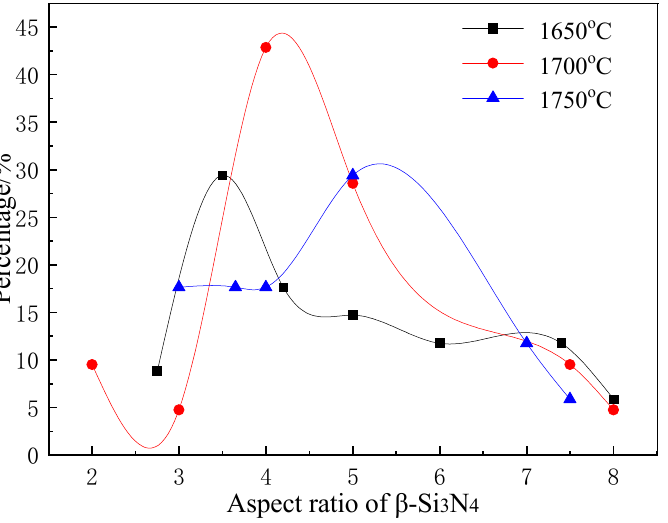
Figure 10. The distribution curves of the aspect ratio of β -Si 3 N 4 grains in SN2, SN4, and SN5 at different hot-pressing temperatures.